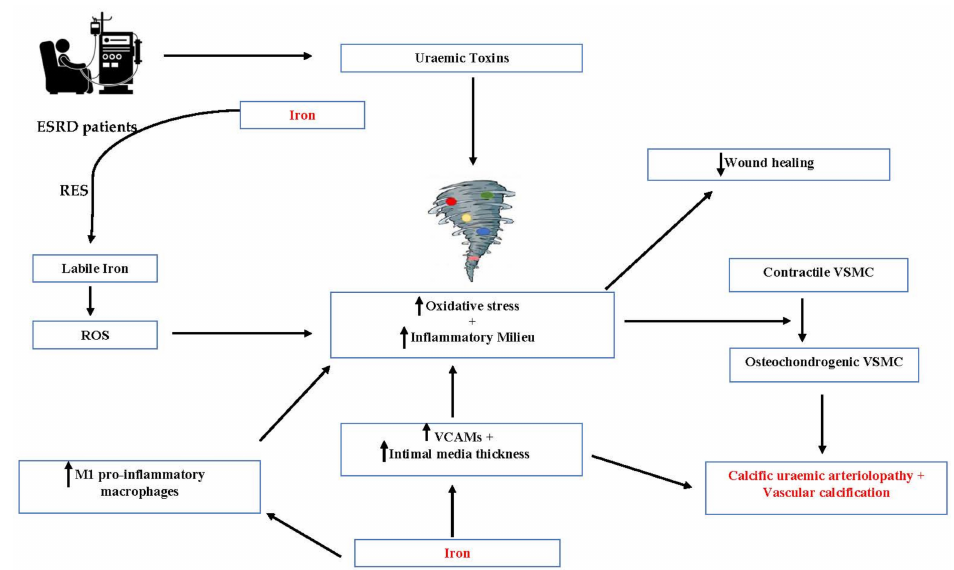
Figure 1. Potential pathophysiological mechanisms of Iron in Calciphylaxis. ESRD—end stage renal disease, RES—reticulo-endothelial system, ROS—reactive oxygen species, VCAMs—vascular cell adhesion molecules, VSMC—vascular smooth muscle